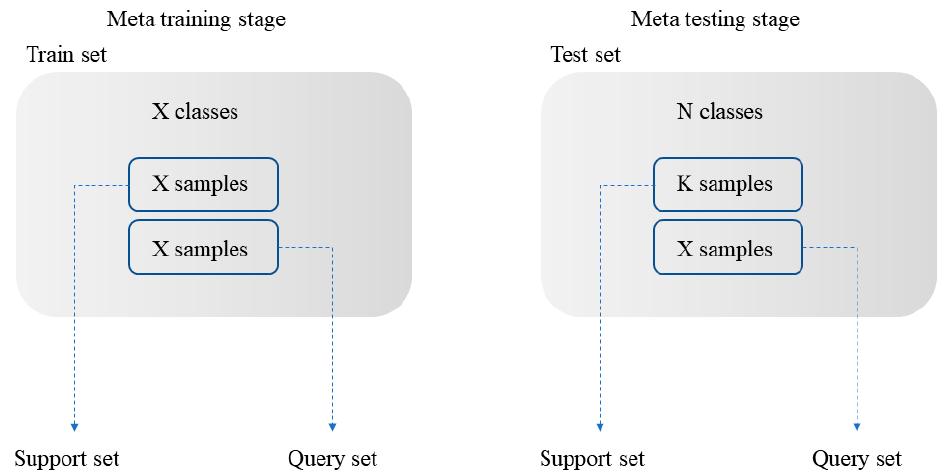
Figure 3. N way K shot classification problem.